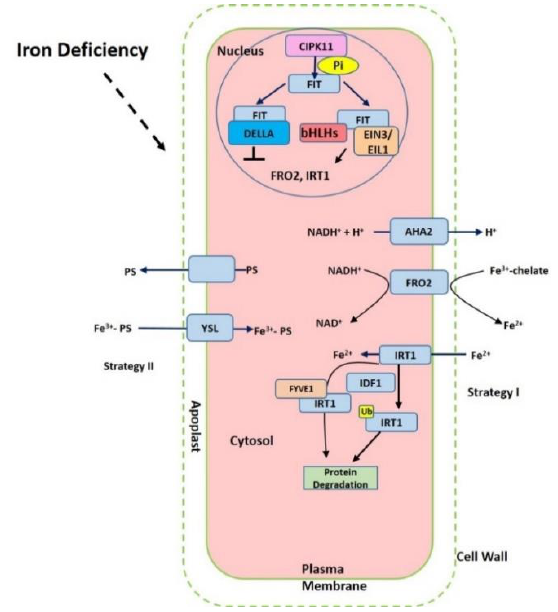
Figure 1. Summary of the iron-deficient response in plant cells. The proton ATPase AHA2, Ferric chelate reductase FRO2 (ferric reduction oxidase), Fe 2+ -regulated transporters iron-regulated transporter (IRT1) and FER-like iron deficiency-induced transcription factor (FIT) are activated under iron starvation, respectively. AHA2 (H + -ATPase) increases the acidification of rhizosphere to facilitate iron solubilization. FRO2 reduces ferric iron to ferrous iron that is imported into the cell via IRT1. The expression of FRO2 , IRT1 can be induced via FIT interaction with other transcription factors such as bHLHs and EIN3/EIL1 but prevented with DELLA.